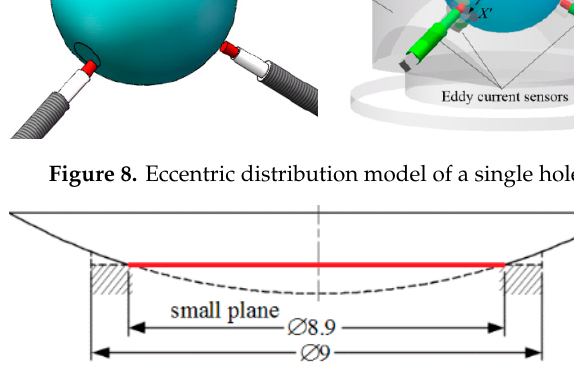
Figure 9. Small plane on the ball